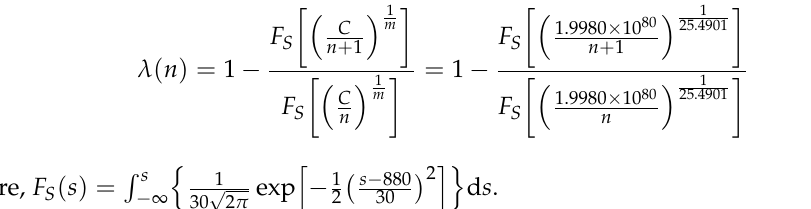
Figure 8. Failure rate curve of Ti-6246 alloy.